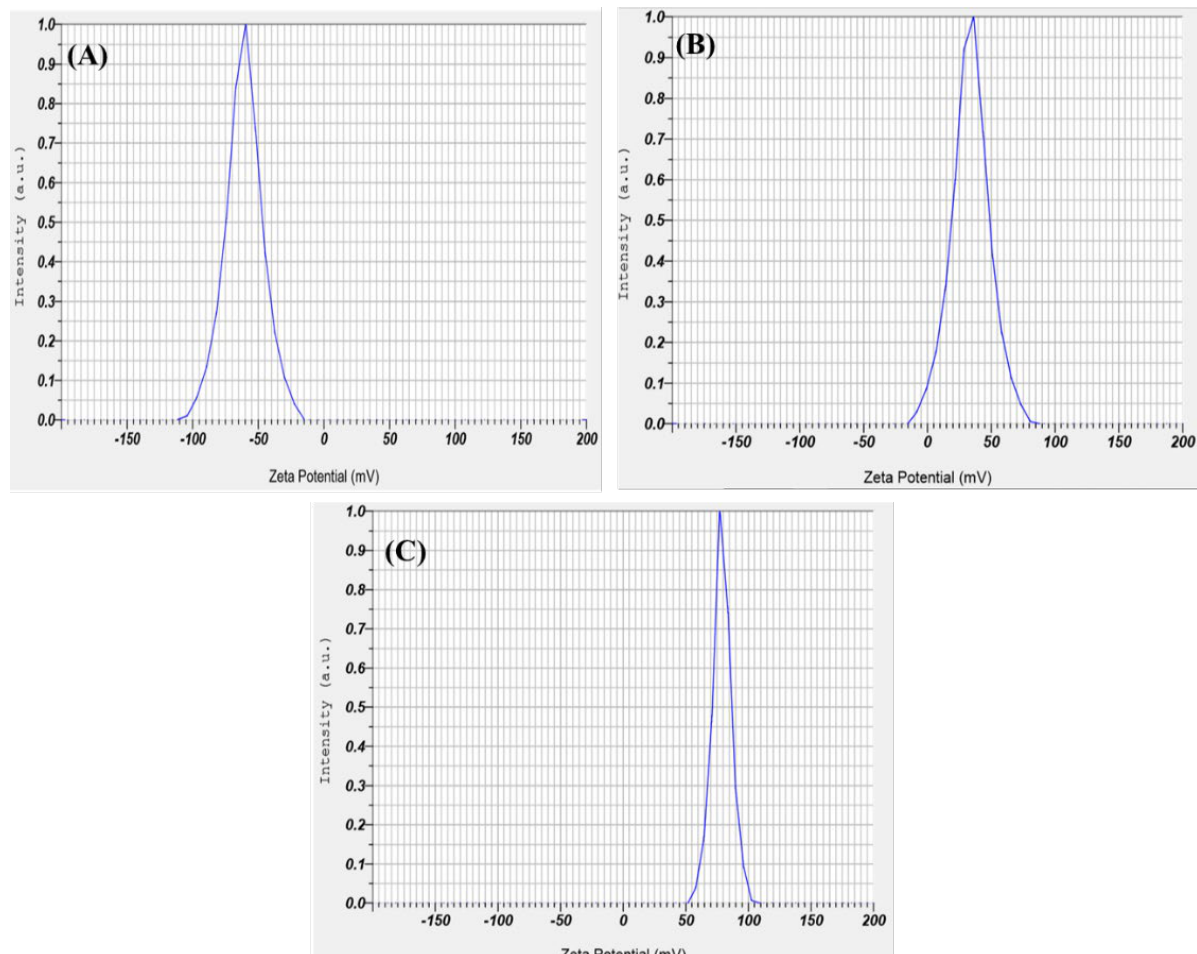
Figure 5. Zeta potential for ( A ) biosynthesized SeNPs using seed extract, ( B ) SeNPs modified with chitosan, and ( C ) PTX-loaded chitosan-modified SeNPs.